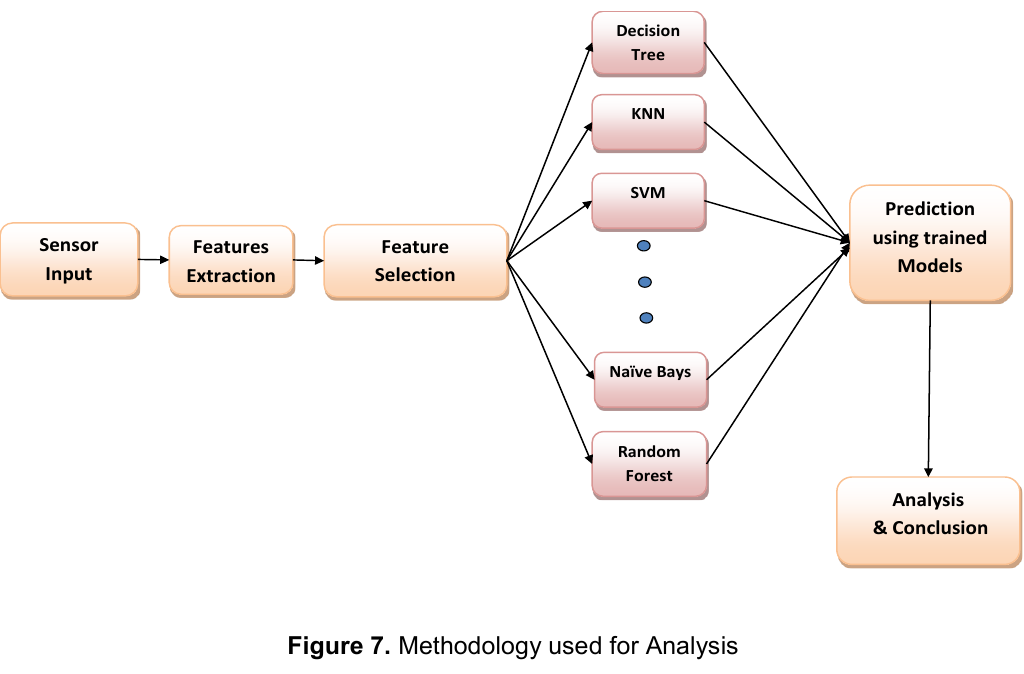
Figure 7. Methodology used for